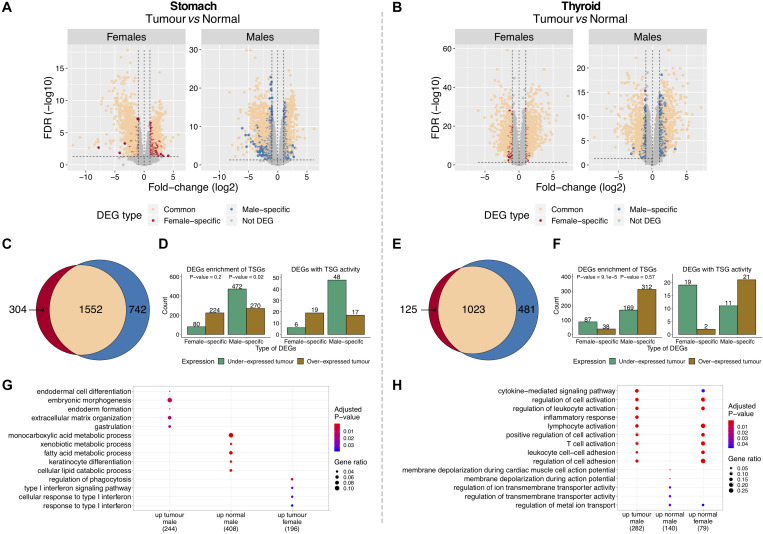
Features of differentially expressed genes (DEGs) between tumor and normal tissues in gastric cancer (GC) and thyroid cancer (TC). (A,B) DEGs between tumor and matched-normal samples in females and males. Vertical line (x = 0): left, genes under-expressed in tumors (over-expressed in normal); right, genes over-expressed in tumors (under-expressed in normal). (C,E) Shared and gender-specific DEGs. (D,F) Gender-specific DEGs over- and under-expressed in tumors. Left, all DEGs and respective enrichment for tumor-suppressor genes (TSGs) (Fisher test P-value). Right, DEGs with TSG activity. (G,H) Gene Ontology (GO) biological processes significantly enriched and shared between gender-specific DEGs (male/female) over-expressed in tumor and normal tissues (up) [false discovery rate (FDR) < 5%].